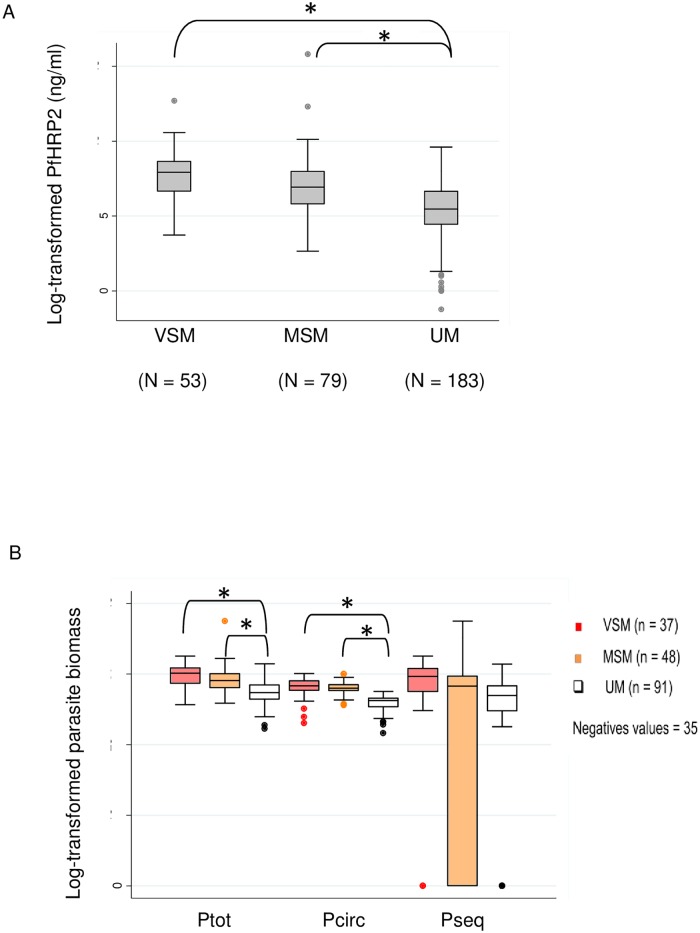
PfHRP2 plasma levels and parasite biomass according to clinical presentation of imported malaria.(A) Log-transformed plasma levels of PfHRP2 in the very severe malaria (VSM), moderately severe malaria (MSM) and uncomplicated malaria (UM) sub-groups. Levels of PfHRP2 were determined on 315 D0 plasma samples by ELISA. (*) corresponds to a significant difference using ANOVA test (p<0.05) and Bonferroni’s correction (p<0.016). (B) Log-transformed estimated total parasite biomass (Ptot), estimated total circulating parasite biomass (Pcirc) and estimated sequestrated parasite biomass (Pseq) respectively in the very severe malaria (VSM) (red box plot), moderately severe malaria (MSM) (orange box plot) and uncomplicated malaria (UM) groups (white box plot). Parasite biomass was estimated for 176 patients using a mathematical approach as described [15] with quantitative plasma levels of PfHRP2 (g/L) determined by ELISA, hematocrit (%), patient body weight (kg) and parasitemia (parasites/μL) on D0 sample. Box plot represents the median [25th percentile-75th percentile] with the extreme value 10th and 90th percentile. (*) corresponds to a significant difference using ANOVA test (p<0.05) and Bonferroni’s correction (p<0.016).